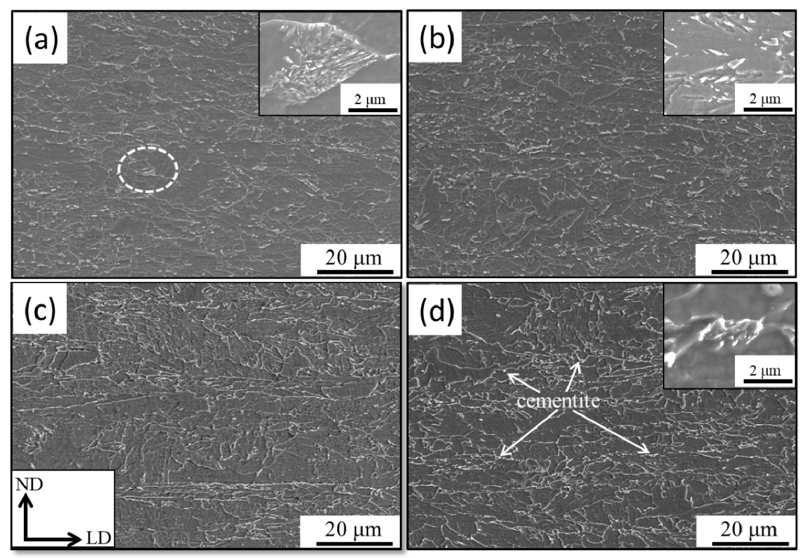
Figure 2. SEM images of as-rolled specimens for ( a ) Nb and ( b ) Nb-Mo steel, respectively, and 600 °C tensile specimens for ( c ) Nb and ( d ) Nb-Mo steel, respectively. (ND represents normal direction, and LD represents rolling direction).